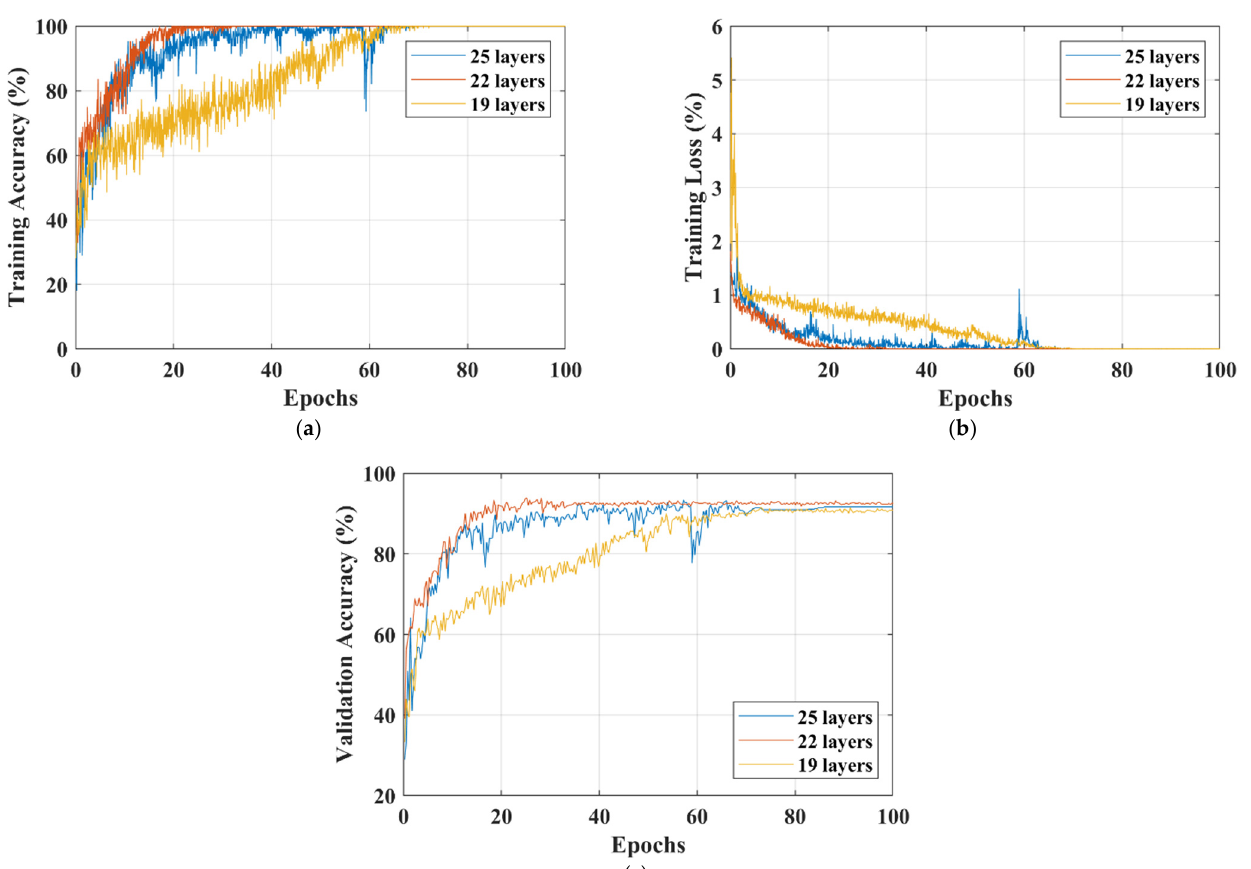
Figure 5. Comparison of different isolated-CNN models for dataset-I; ( a ) Training-accuracy curves; ( b ) Training-loss curves; ( c ) Validation-accuracy curves.